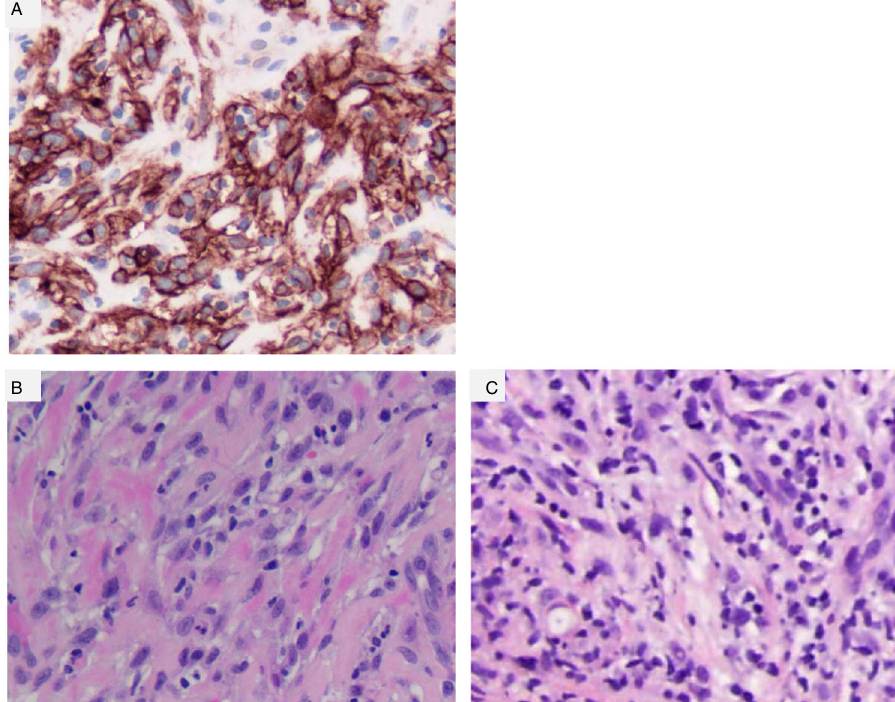
Fig. 3 Histopathologic features of the MPBC obtained by punch biopsy from peripheral chest wall lesion (inferolateral margin). a Baseline PD- L1 IHC stain at 20×. One-hundred percent of tumor cells stain positive for PD-L1 (95% at 3 + intensity, 5% at 2 + intensity), b Tumor H and E stain at 40× at baseline and c after treatment with pembrolizumab (biopsy cycle 3, day 1) with increase in TIL from baseline (10 to